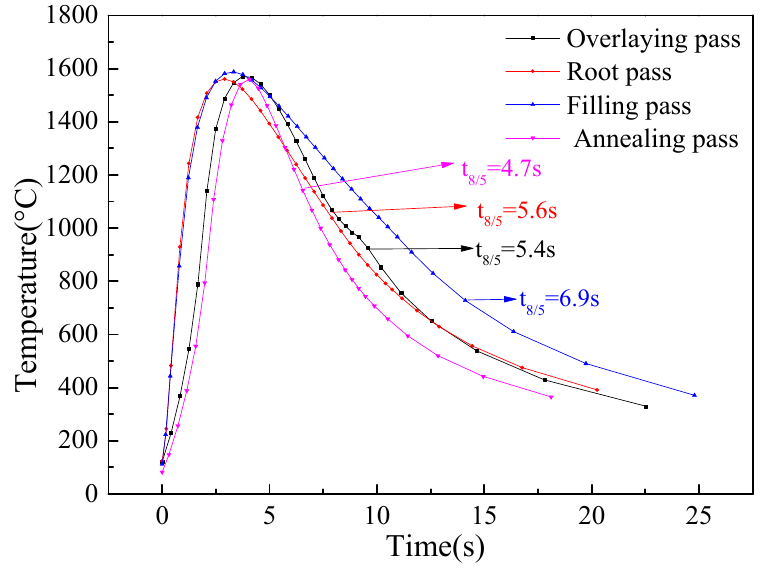
Figure 9. Welding thermal cycles.